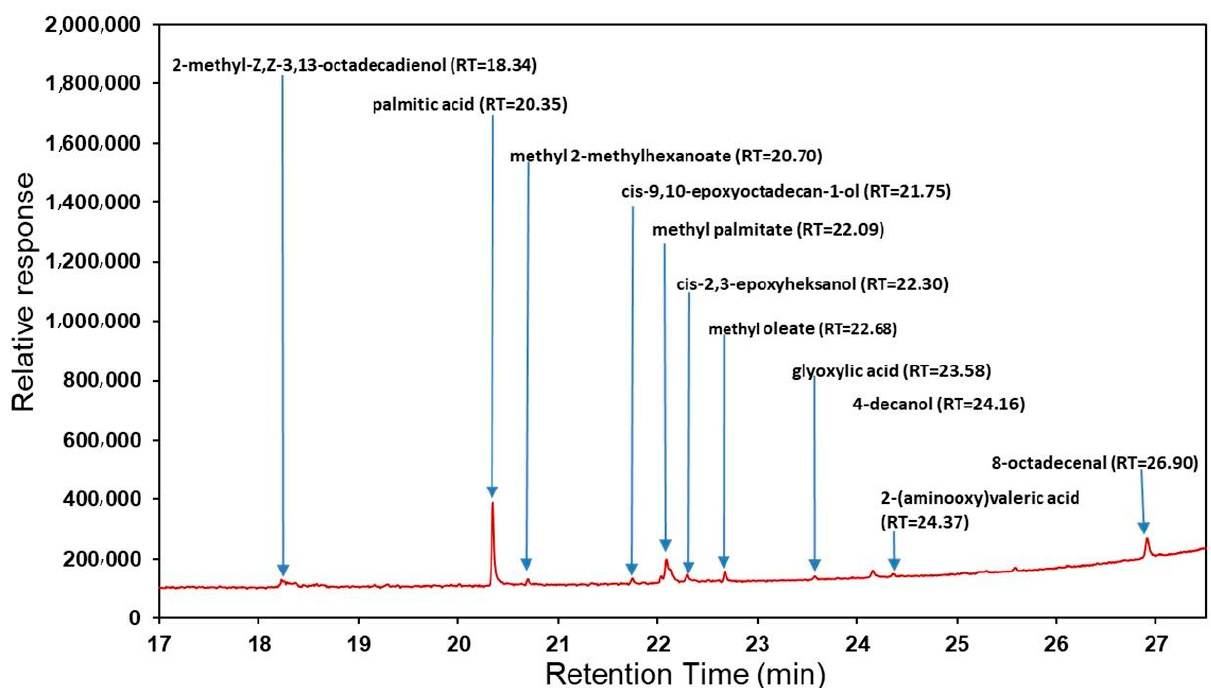
Figure 1. GC-MS chromatogram of the ethanolic extracts of E. angustifolium (FEE).